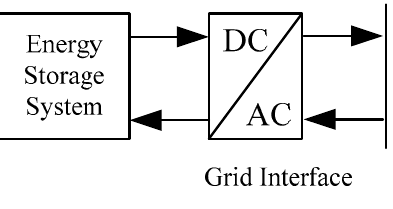
Figure 3. Energy storage system (ESS).